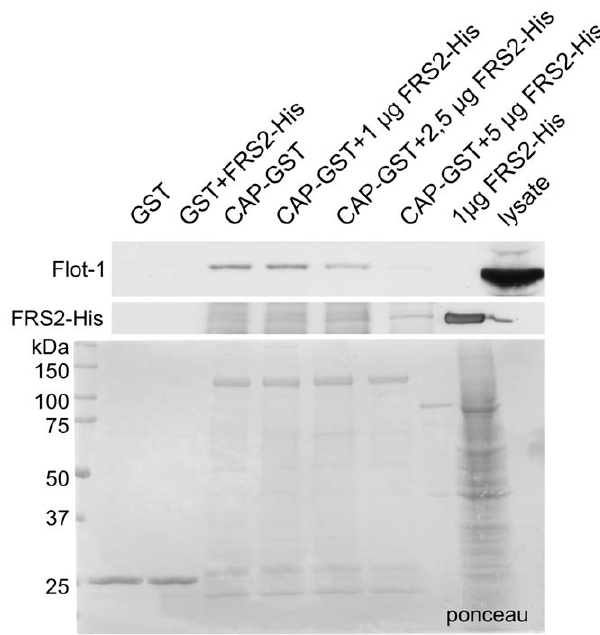
Figure 7. Flot-1 and CAP compete for the binding to FRS2. CAP- GST was immobilized to sepharose and incubated with HeLa cell lysates in the presence of increasing amounts (1–5 m g) of purified FRS2-His. The binding of endogenous flot-1 from the lysates was analyzed by Western blot (upper blot). Middle panel shows the blot for FRS2-His and the lowermost one a ponceau staining of the GST